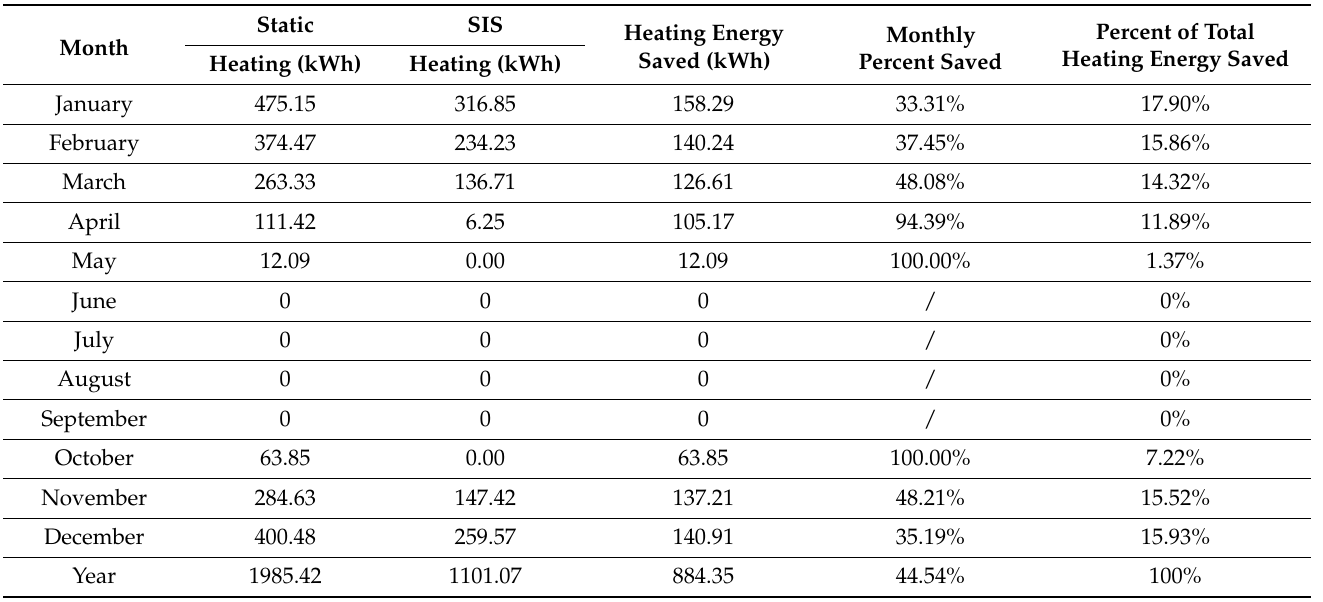
Table 4. Comparison of heating energy consumption for static and dynamic windows for the prototypical apartment unit.